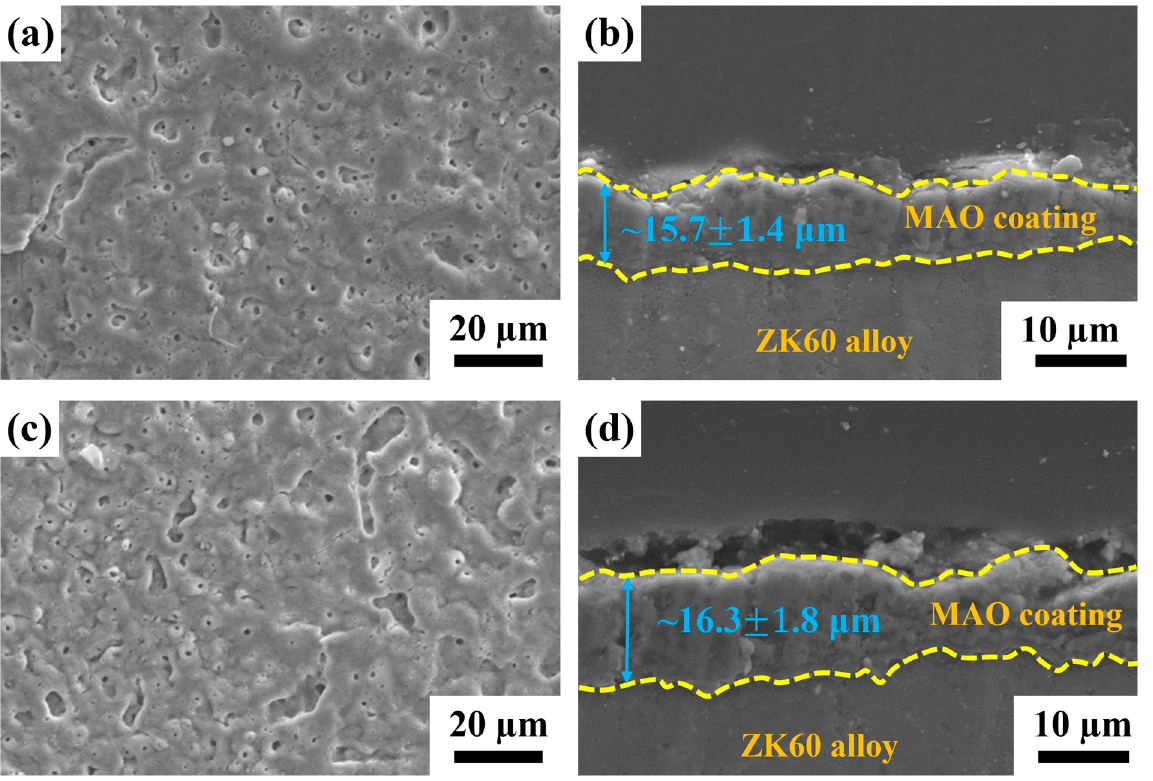
Figure 1. SEM morphology and cross-sectional microstructure of ( a , b ) the MAO and ( c , d ) the MAOCa coated ZK60 samples.